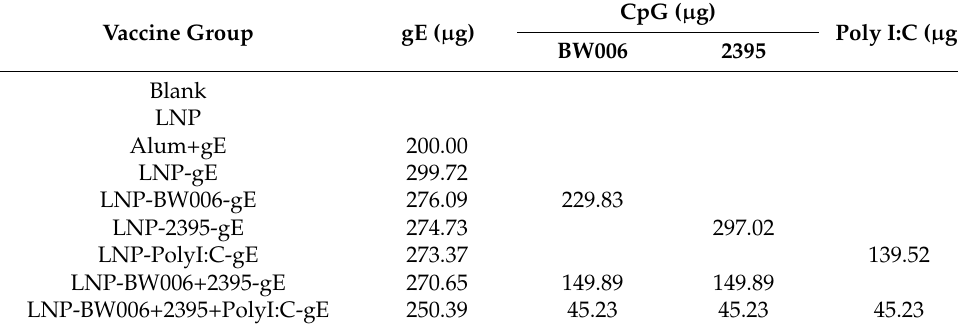
Table 2. Vaccine compositions of 20